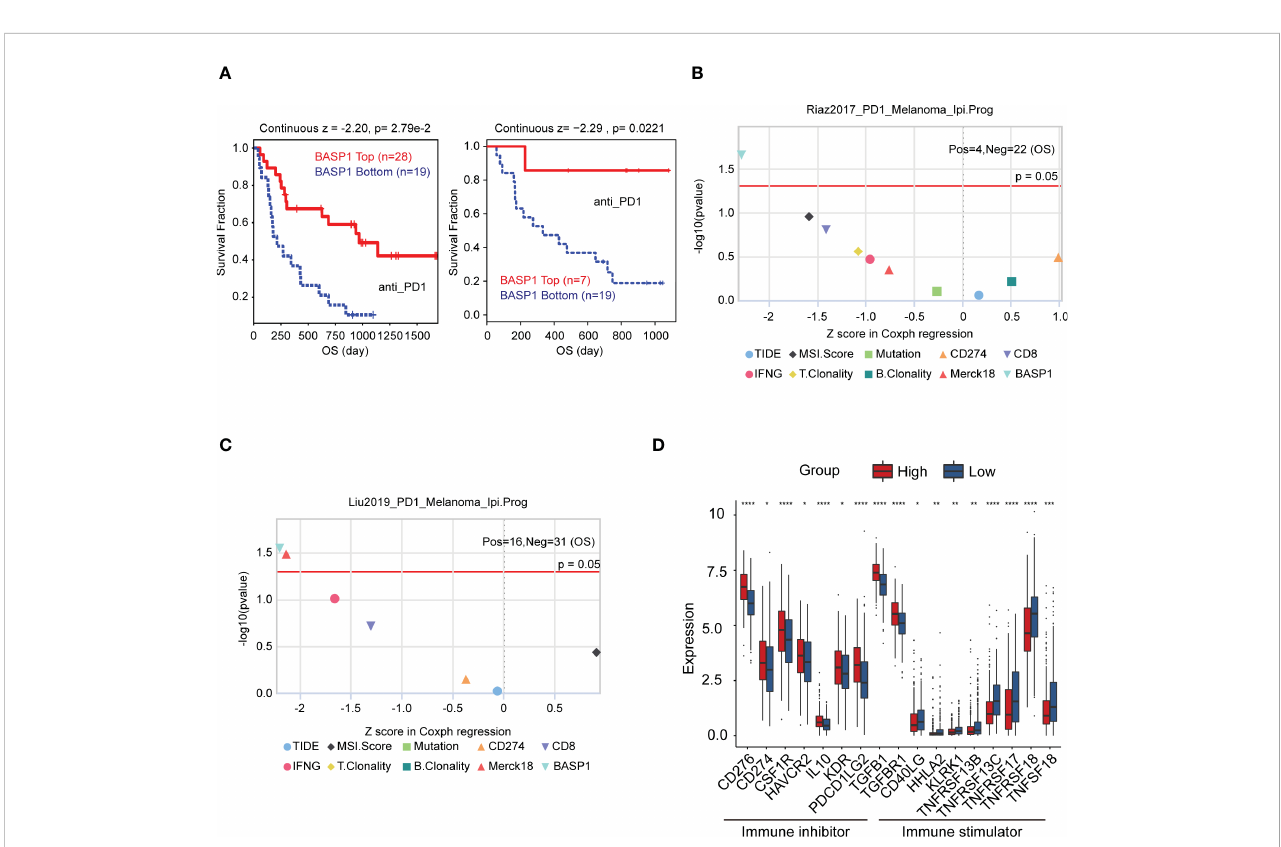
FIGURE 3 The relationship between BASP1 expression and immunotherapy. (A) Overall survival of BASP1 high group and BASP1 low group in melanoma patients that accepted anti-PD1 therapy. (B, C) The evaluation of immunotherapy biomarkers in TIDE. (D) Boxplot of the immune molecules expressions in BASP1 high and BASP1 low HNSCC patients. * p < 0.05; ** p < 0.01; *** p < 0.001; **** p <